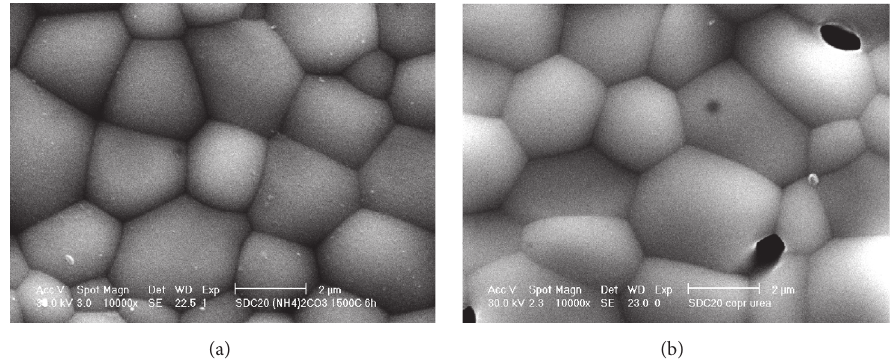
Figure 6: SEM micrographs of sintered pellets of samples C-SDC20 (a) and U-SDC20 (b) at high magnification.